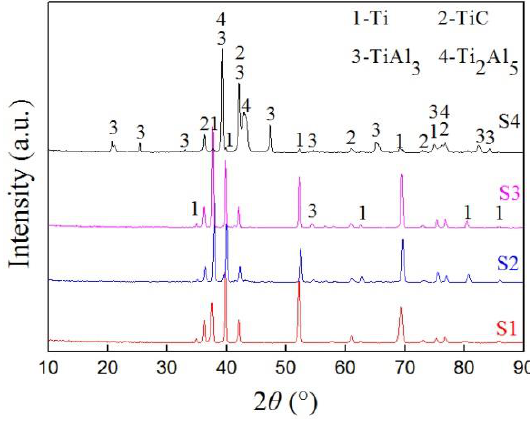
Figure 5. The XRD patterns of samples S1 – S4.